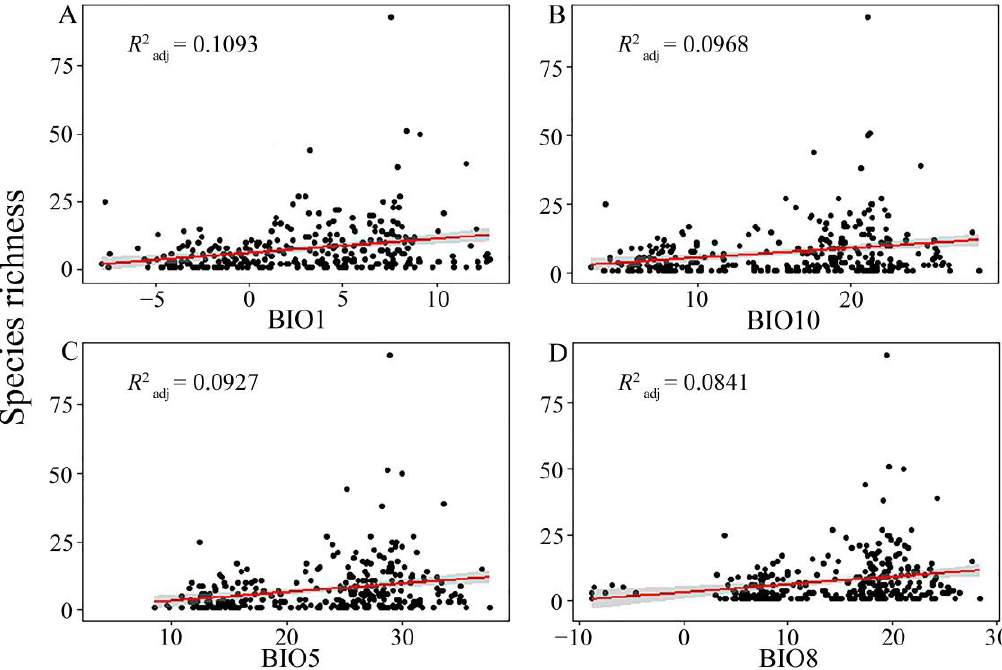
Figure 4. Relationship between species richness and the top four correlation variables based on the generalized linear models (GLMs). ( A ) BIO1, annual mean temperature; ( B ) BIO10, mean temperature of warmest quarter; ( C ) BIO5, max temperature of warmest month; ( D ) BIO8, mean temperature of wettest quarter. Table 1. The generalized linear models (GLMs) used to evaluate the explanatory power of each environmental variable for species richness ( R 2adj , %).